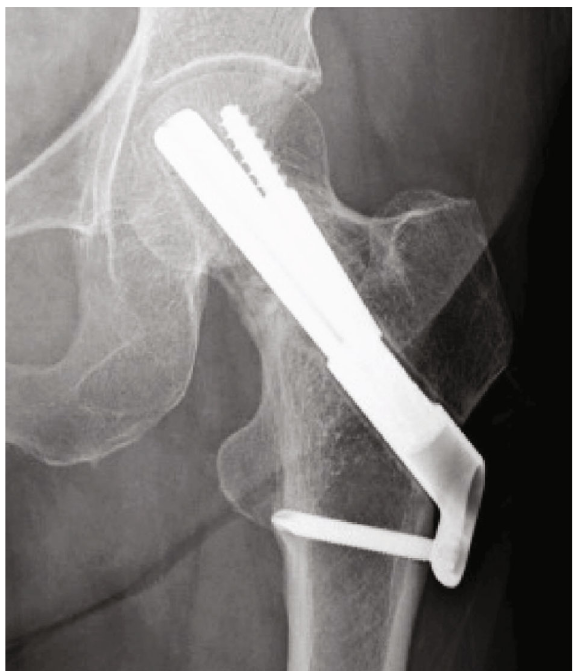
Figure 6: A left hip radiograph obtained at 1 year postoperatively demonstrating a radiolucent line around the implant that was not present immediately